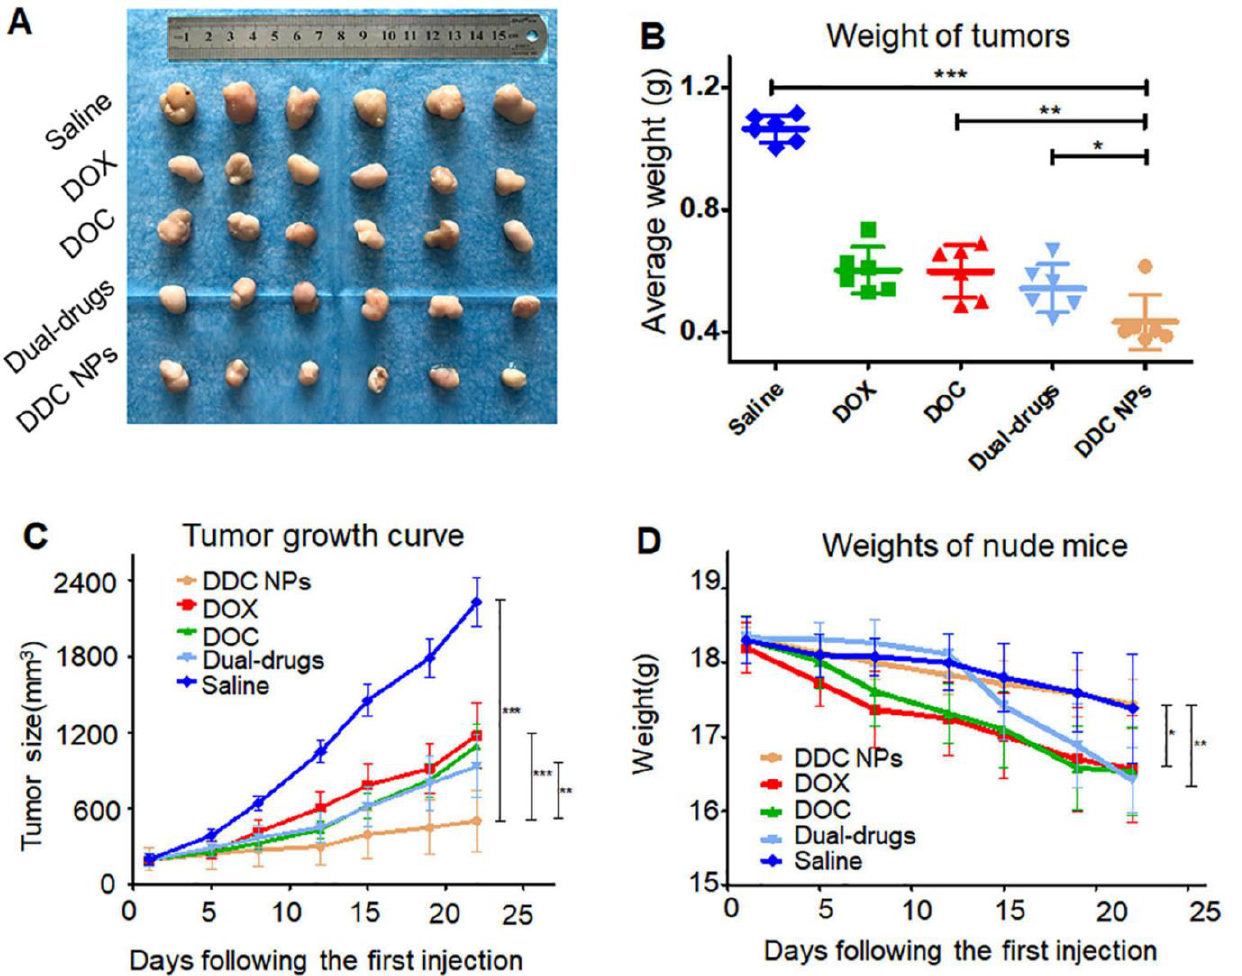
Figure 13. Anti-tumor efficiency of nanoparticles. ( A ) Images of tumors. ( B ) Tumor weight treated by each group. ( C ) Growth patterns of tumors. ( D ) Body weight changes affected by test groups. (For statistical significance, the notation of * represents p < 0.05, ** represents p < 0.01, and *** represents p < 0.001). Reproduced from Li et al. [200], © 2019 Li, Zhan, Chen, Jha and Chen.